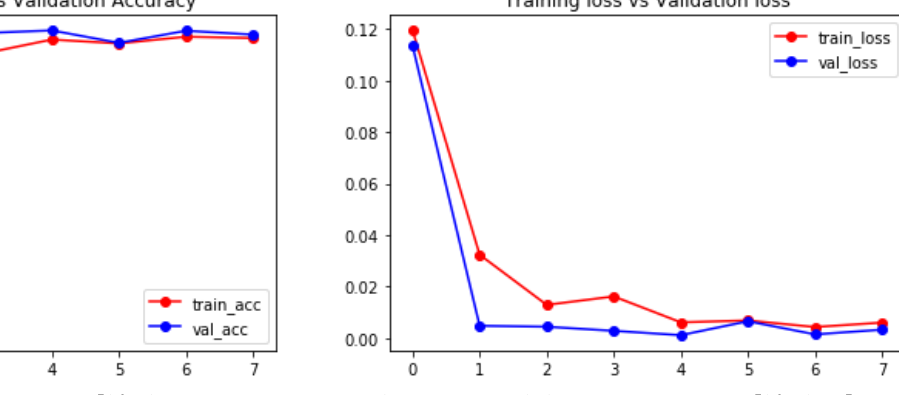
Figure 9. Training accuracy vs. validation accuracy Figure 10. Training accuracy vs. validation loss